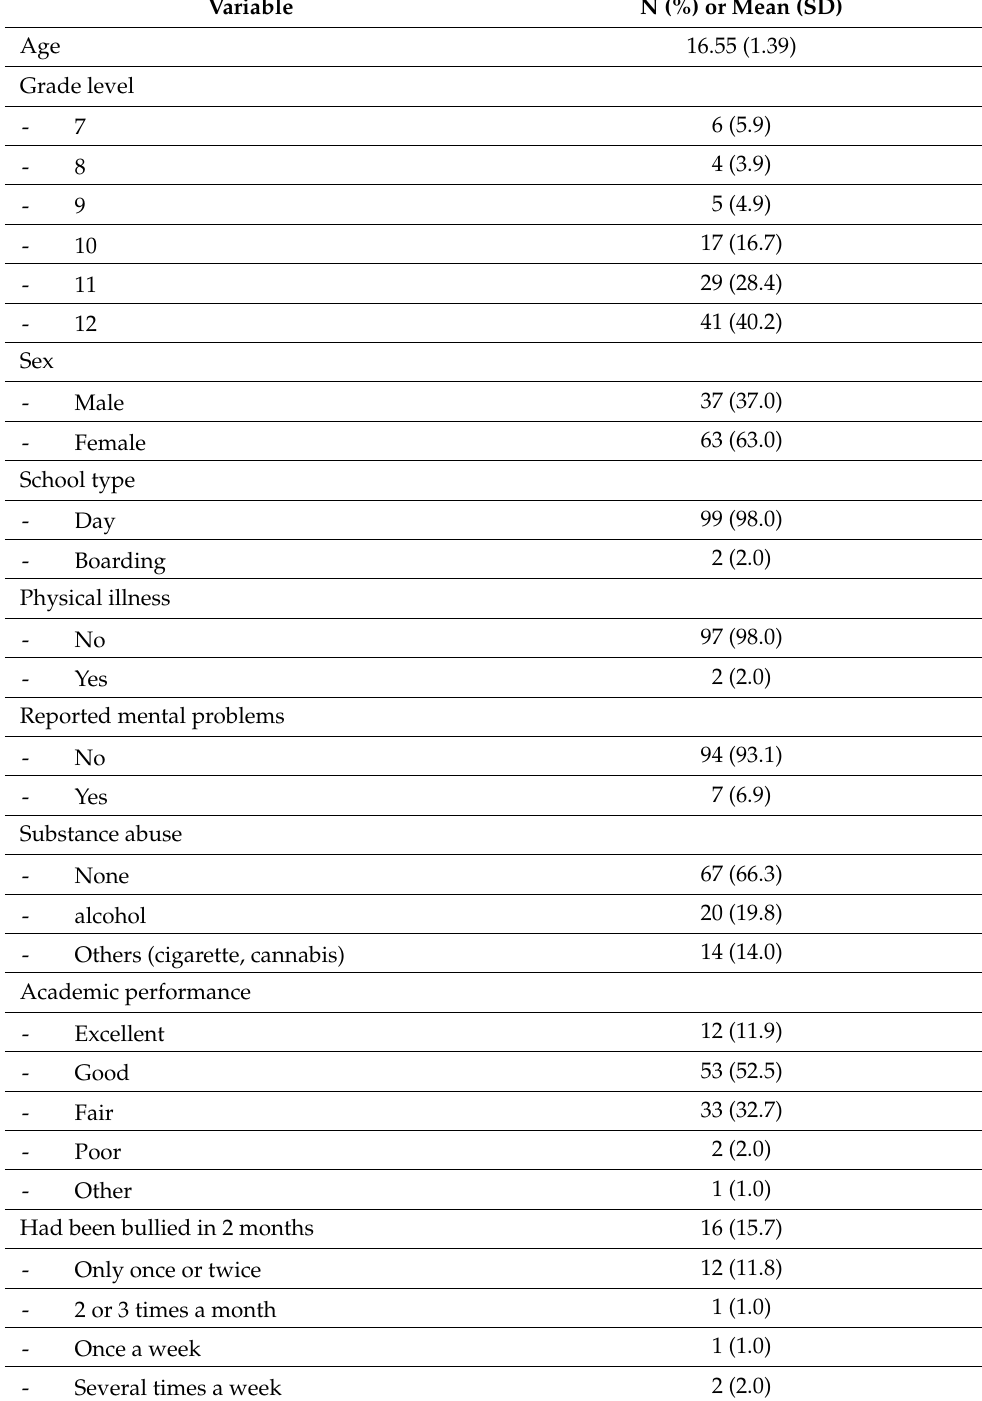
Table 1. Sociodemographic data of the